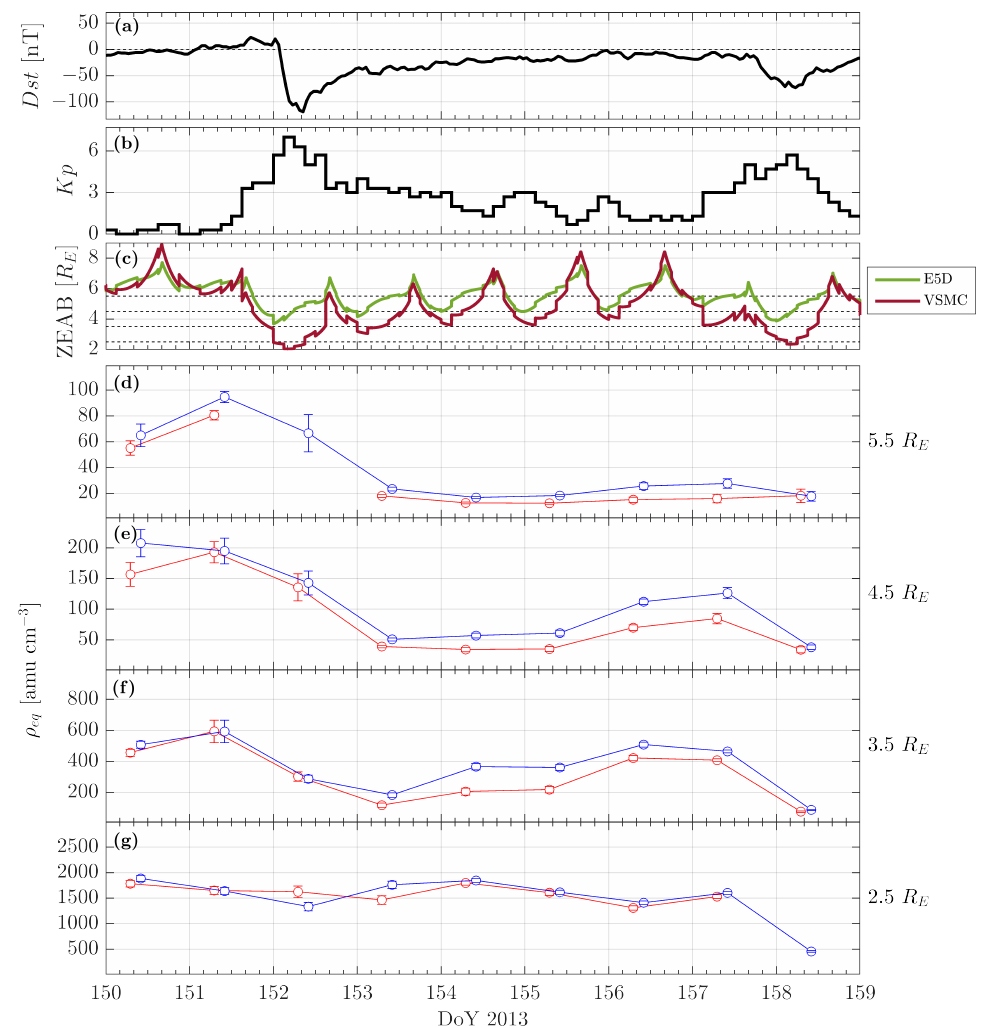
Figure 7. Panels ( a – b ) show the geomagnetic indices Dst and Kp . Panel ( c ) shows the ZEAB position estimated from E5D and VSMC models. The dashed lines are the geocentric distances, 2.5, 3.5, 4.5 and 5.5 R E . Panels ( d – g ) show the mass density variation evaluated at 09:00 (in red) and 12:00 MLT (in blue) for r eq = 2.5, 3.5, 4.5 and 5.5 R E ,